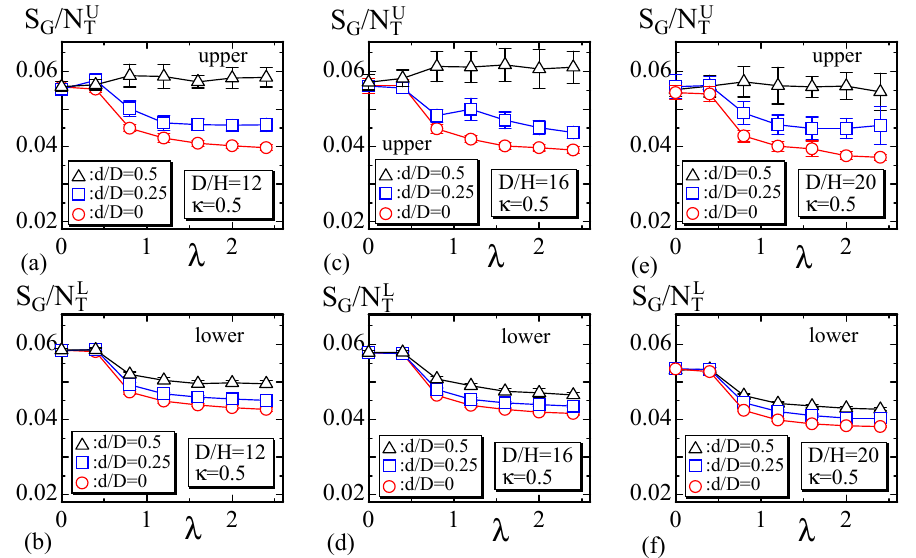
Figure 11. S G / N U , L vs. λ obtained for the disk with size ( a , b ) D / H = 12, ( c , d ) D / H = 16, T and ( e , f ) D / H = 20. The data S G / N U ( a , c , e ) for the upper surface depend on d / D , and for the T lower surface, only a slight dependence can be